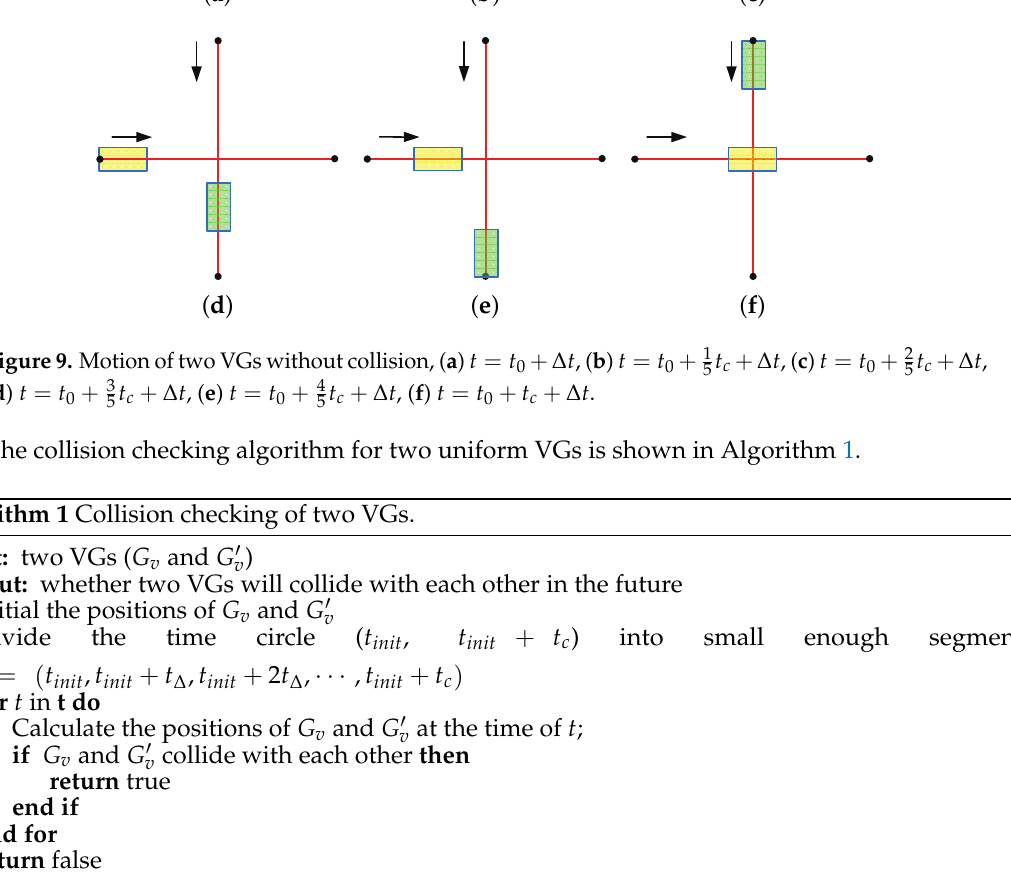
t c + ∆ t , ( c ) t = t 0 + 2 t c + ∆ t , 5 5